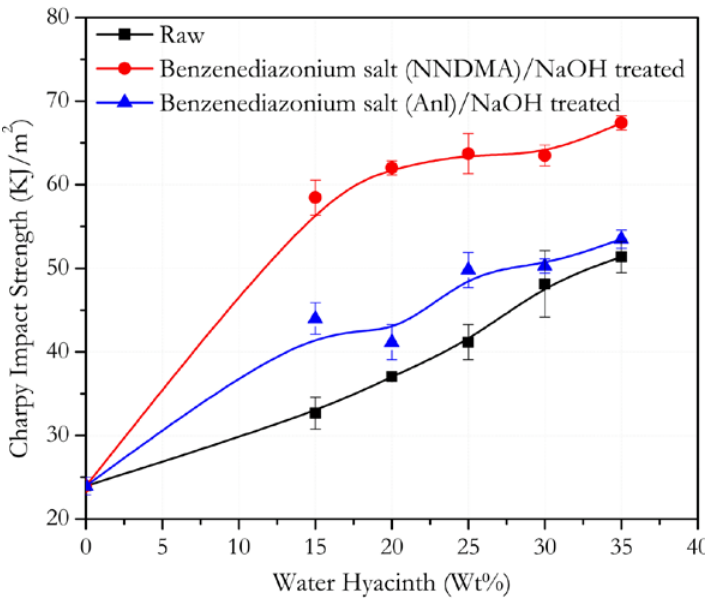
Figure 7: Impact strength versus fiber loading curves of WH-PP composites